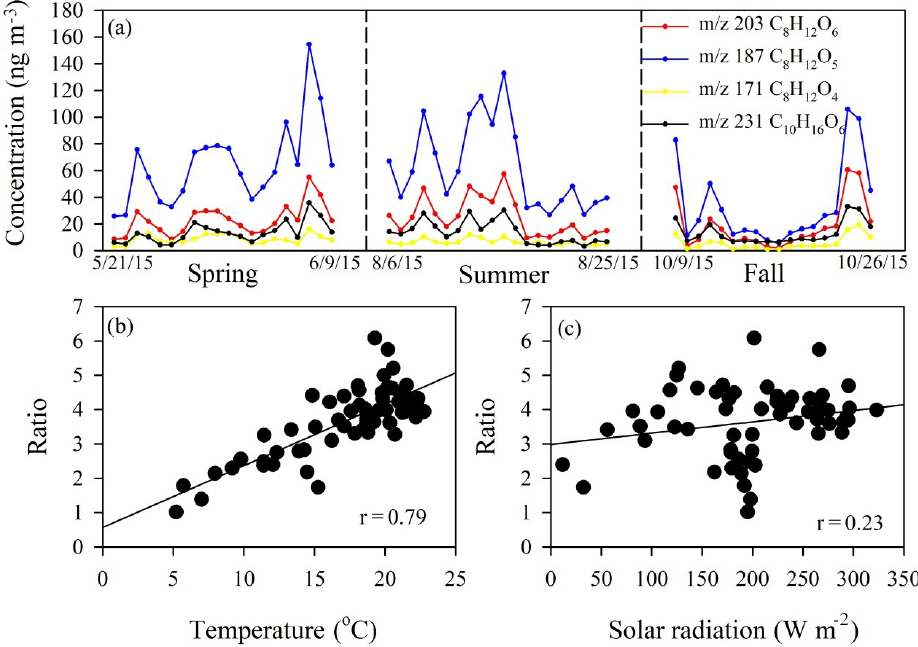
Figure 4. (a) Time series of these four identified terpenoic acids: 3-methyl-1,2,3-butanetricarboxylic acid (MBTCA, C 8 H 12 O 6 , m/z 203), 2-hydroxyterpenylic acid (C 8 H 12 O 5 , m/z 187), terpenylic acid (C 8 H 12 O 4 , m/z 171), and diaterpenylic acid acetate (DTAA, C 10 H 16 O 6 , m/z 231); (b) correlation of concentration ratios of higher-generation oxidation products (C 8 H 12 O 6 , m/z 203 and C 8 H 12 O 5 , m/z 187) to early oxidation fresh SOA products (C 8 H 12 O 4 , m/z 171 and C 10 H 16 O 6 , m/z 231) with temperature and (c) with solar